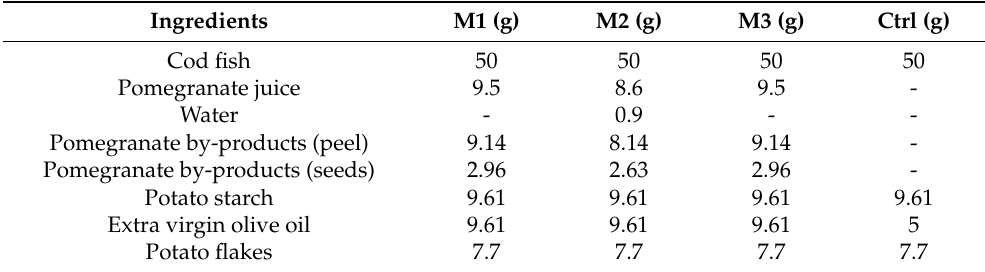
Table 1. Formulation of cod fish burgers with and without pomegranate